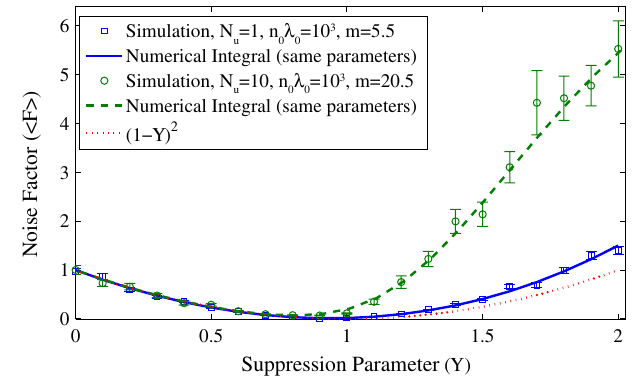
FIG. 10. Simulations show the noise factor for both N u ¼ 1 and N u ¼ 10 as a function of (cid:2) . When the approximation (cid:10) =n k 2 N (cid:5) 1 is valid, the noise scales as ð 1 (cid:1) (cid:2) Þ 2 . We u 0 0 have chosen m so that ~ h u ð k Þ is approximately